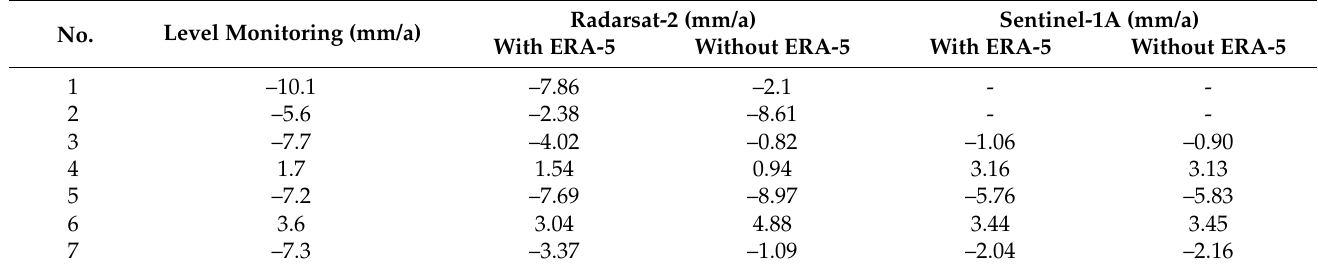
Table 5. Comparison of PS point deformation rate and leveling measurement